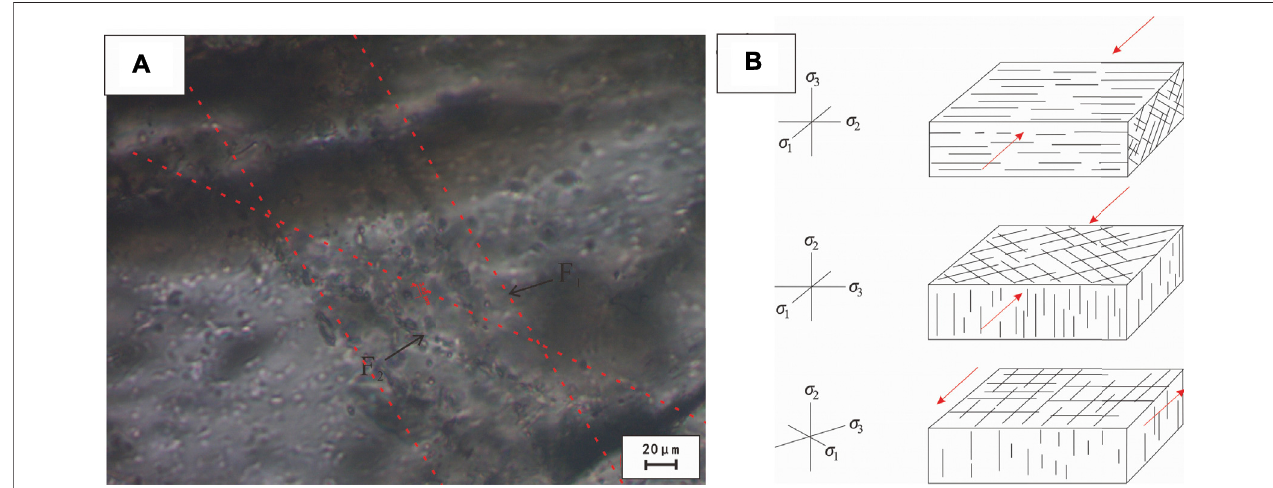
FIGURE 8 | (A) Thin-section photomicrograph of the X-shaped conjugated FIP which is indicated using a red dotted line, LN2-3-1, 4,870.7 m. (B) The relation between the maximum principal stress direction and X-shaped conjugated FIP.